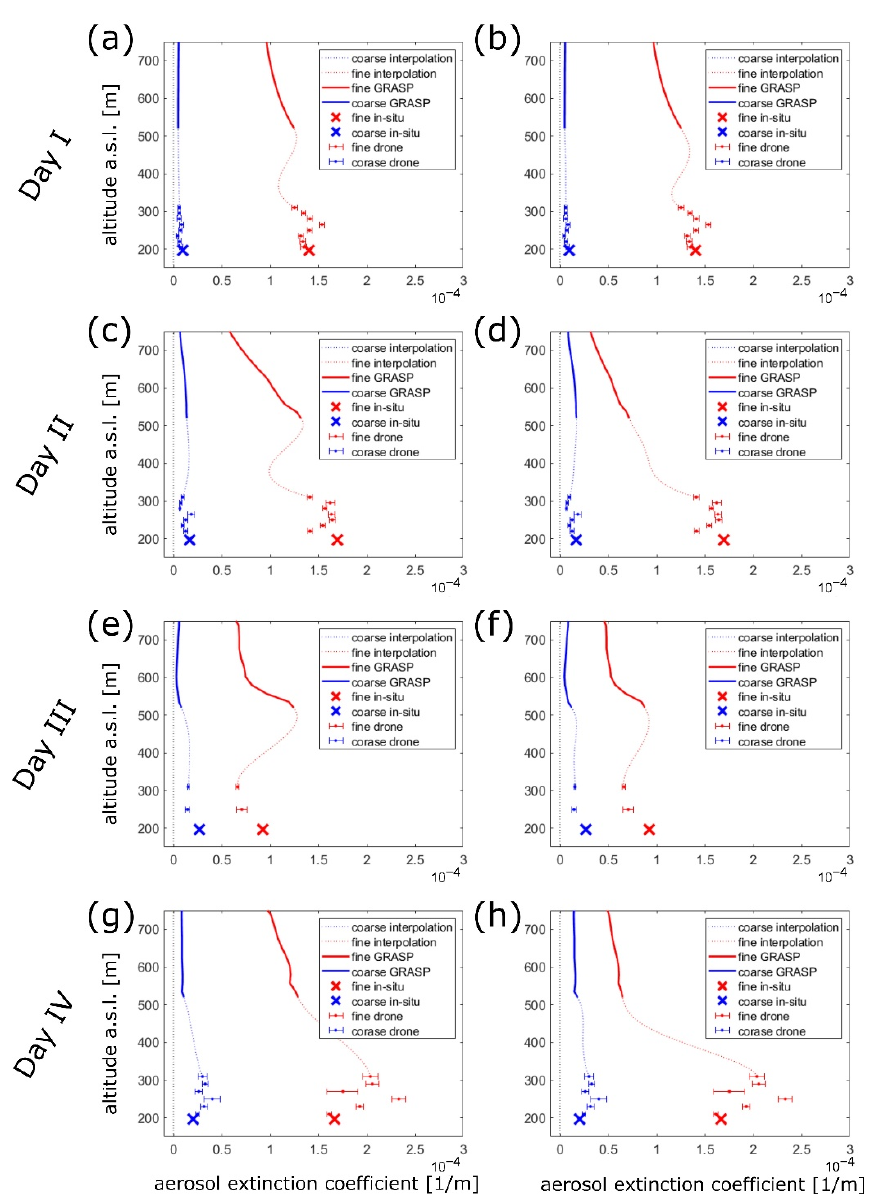
Figure 3. Interpolation of aerosol extinction profiles between GRASP and UAV retrieval ranges. Subplots on the left ( a , c , e , g ) depict the application of third-order polynomials to original profiles while the right-hand-side ( b , d , f , h ) subfigures show the result of the use of fourth-order polynomials followed by iterative renormalization of the reconstructed profiles (GRASP and interpolation regions) to the columnar AOD values.